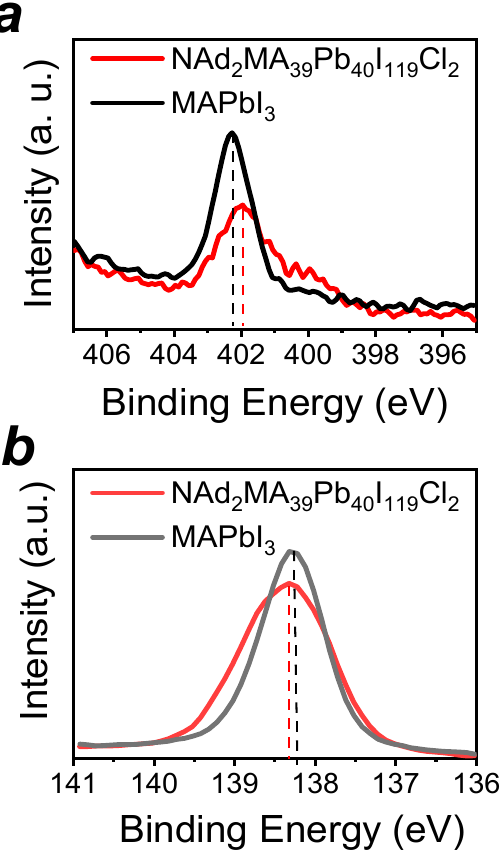
Figure 6. XPS ( a ) N 1s and ( b ) Pb 4f 7/2 spectra of pristine films of MAPbI 3 and NAd 2 MA 39 Pb 40 I 119 Cl 2 .